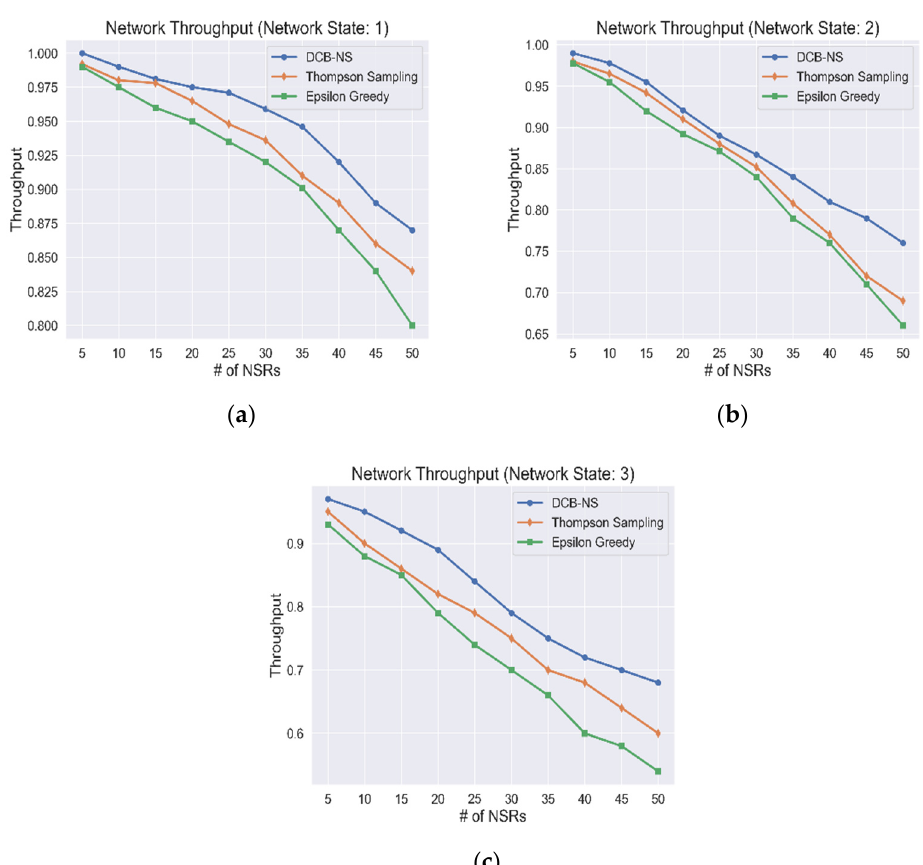
Figure 6. Network Throughput values based on (a) Network State 1, ( b ) Network State 2, and ( c ) Network State 3.